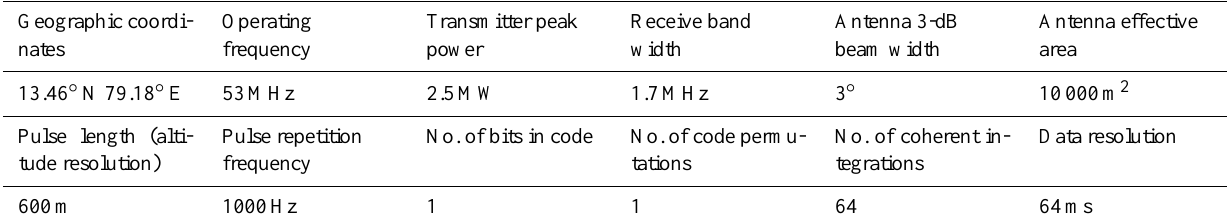
Operating frequency